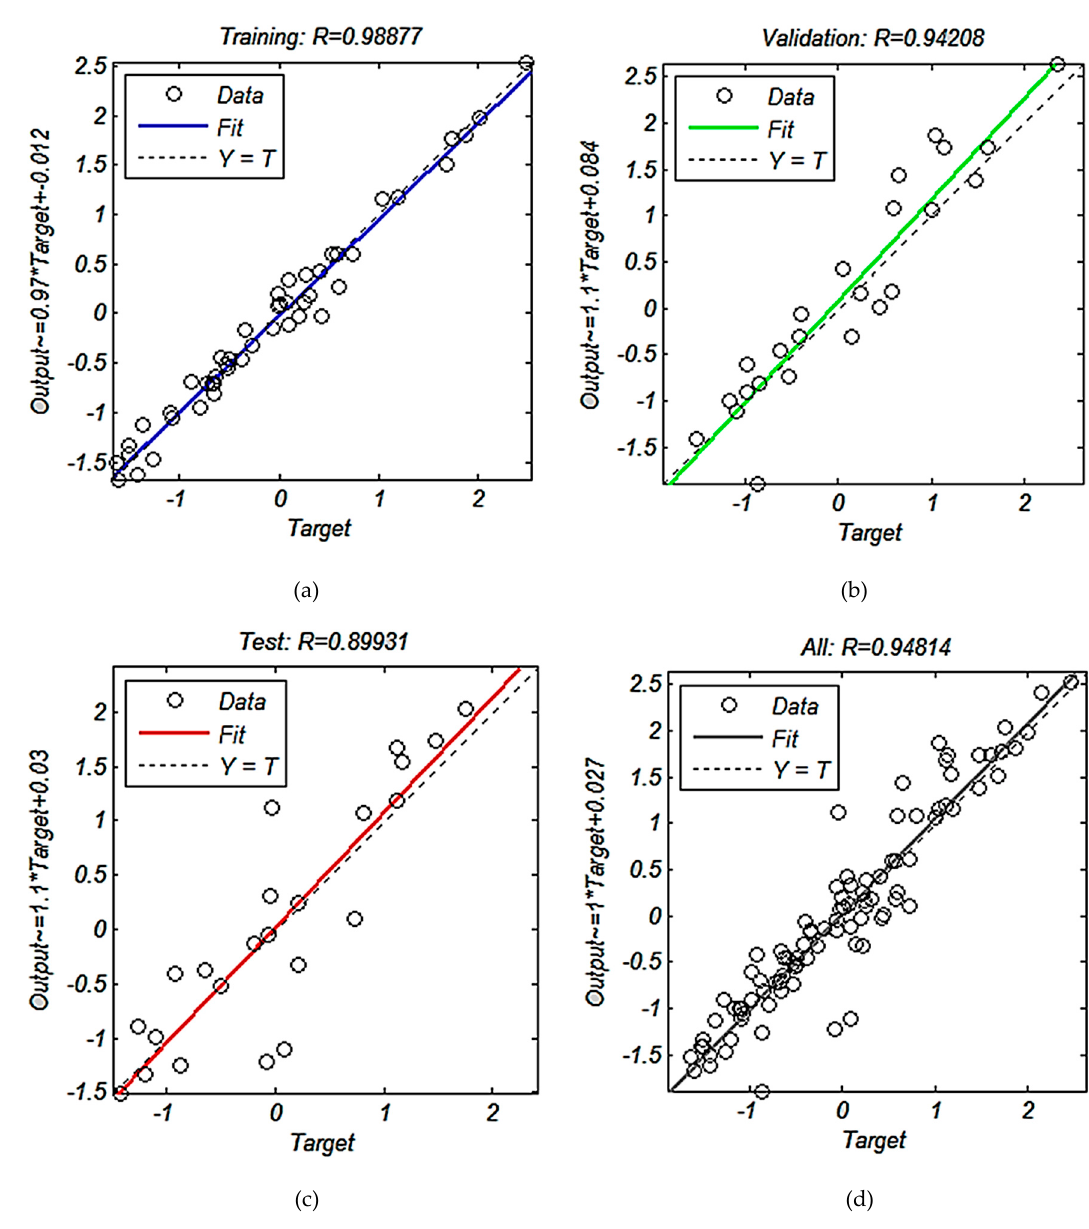
Figure 8. Network regression chart with 24 neurons in the first layer and 26 neurons in the second layer.